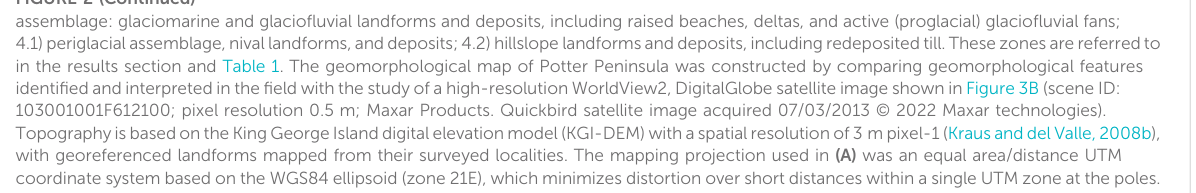
FIGURE 2 (Continued) assemblage: glaciomarine and glacio fl uvial landforms and deposits, including raised beaches, deltas, and active (proglacial) glacio fl uvial fans; 4.1)periglacialassemblage,nivallandforms,anddeposits;4.2)hillslopelandformsanddeposits,includingredepositedtill.Thesezonesarereferredto in the results section and Table 1. The geomorphological map of Potter Peninsula was constructed by comparing geomorphological features identi fi edandinterpreted inthe fi eldwiththestudy ofahigh-resolutionWorldView2,DigitalGlobe satellite imageshown inFigure 3B(scene ID: